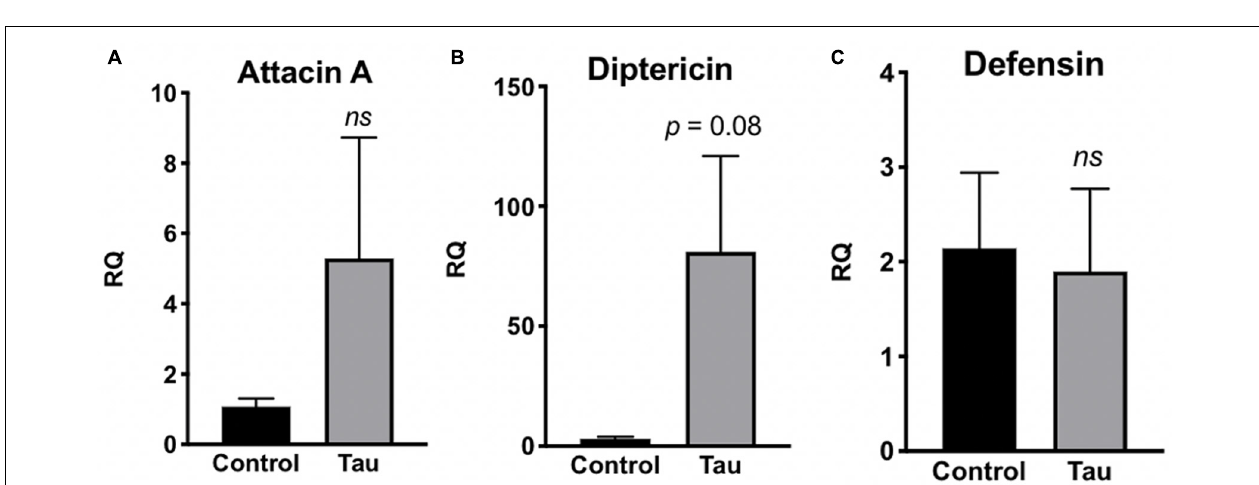
FIGURE 2 | Tau transgenic flies show an increased gut bacterial load compared to controls. CFU counts of diluted tau transgenic fly homogenates were increased on both (A) MRS agar ( n = 6, t -test **** p < 0.0001) and (B) nutrient agar ( n = 5, t -test ** p < 0.01). Data are shown as average ± SEM.